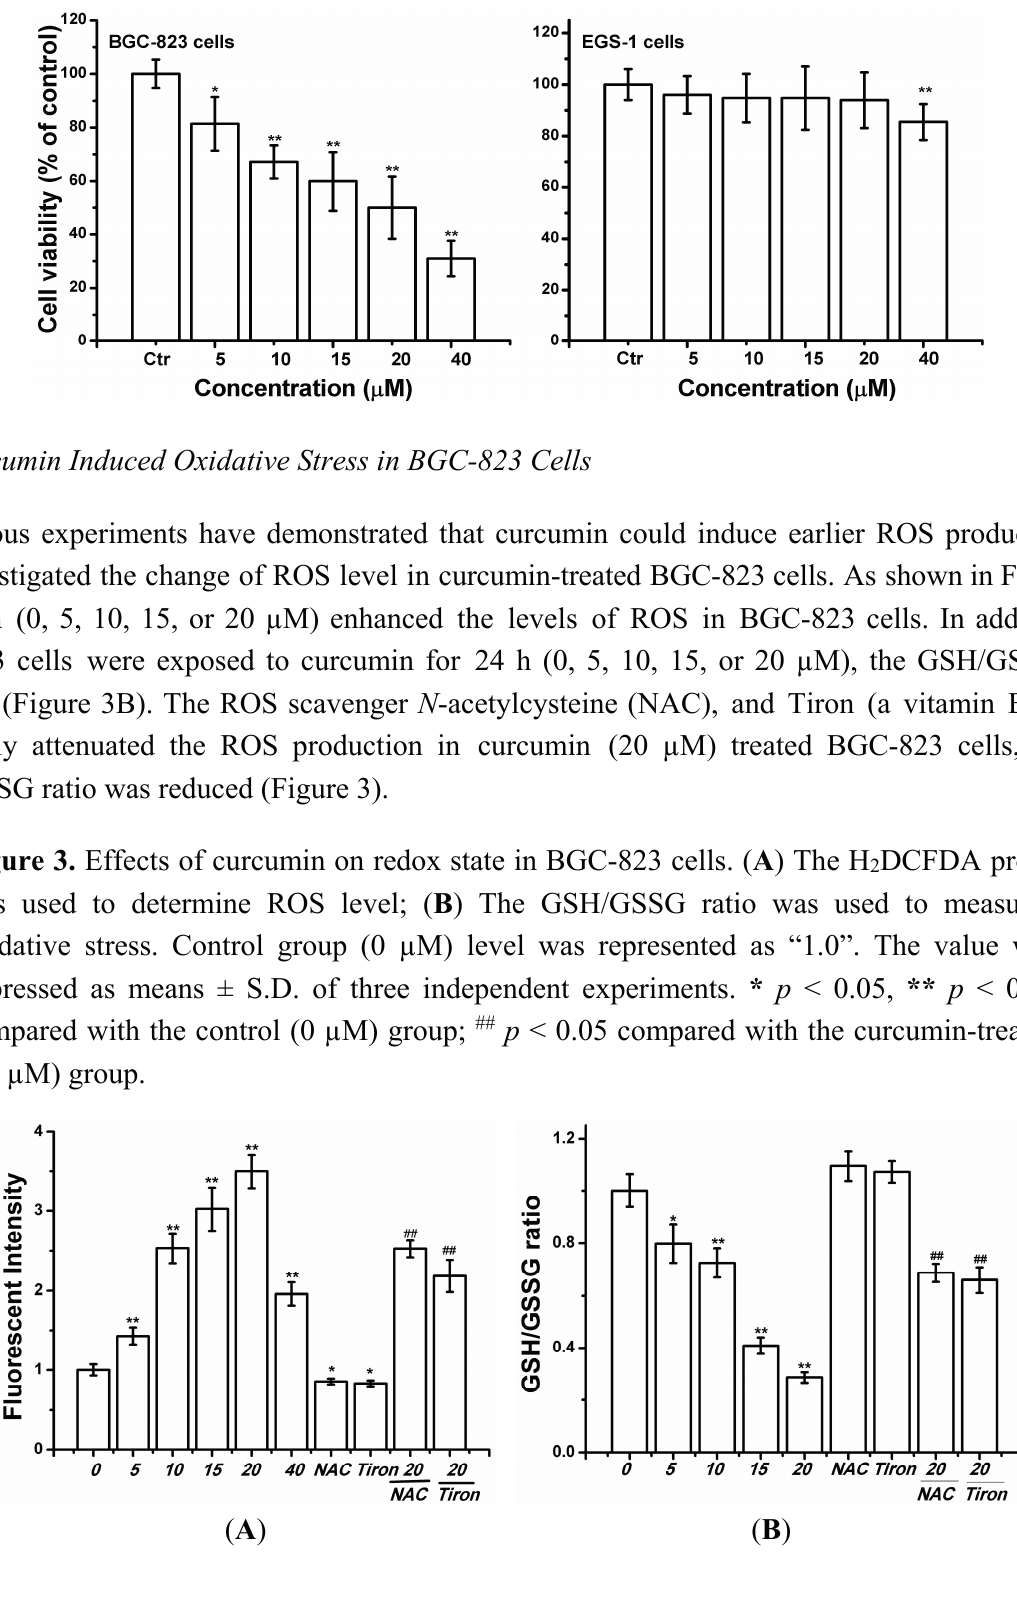
Figure 2. Effects of curcumin on cell growth of BGC-823 or EGS-1 cells. The MTT staining assay was used to assess cell viability. After 24 h treatment, curcumin (0–40 µM) significantly decreased of BGC-823 or EGS-1 cells cell viability with a concentration-dependent manner. The value was expressed as means ± S.D. of three independent experiments. * p < 0.05, ** p < 0.01 compared with the control (0 µM) group.